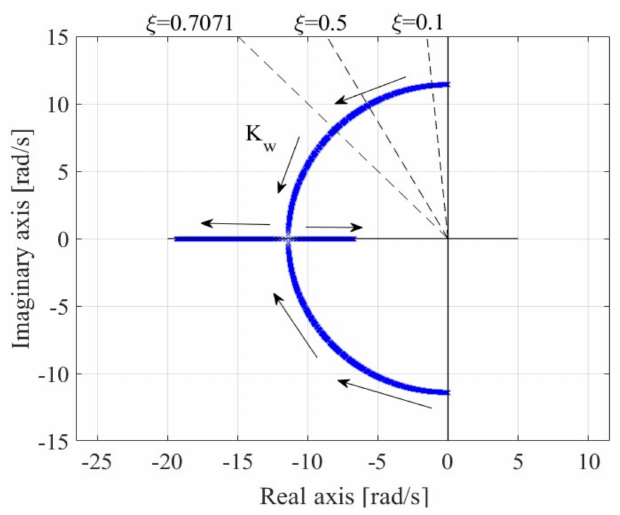
Figure 9. Poles loci of the transfer function ∆ δ / ∆ ω g under K w